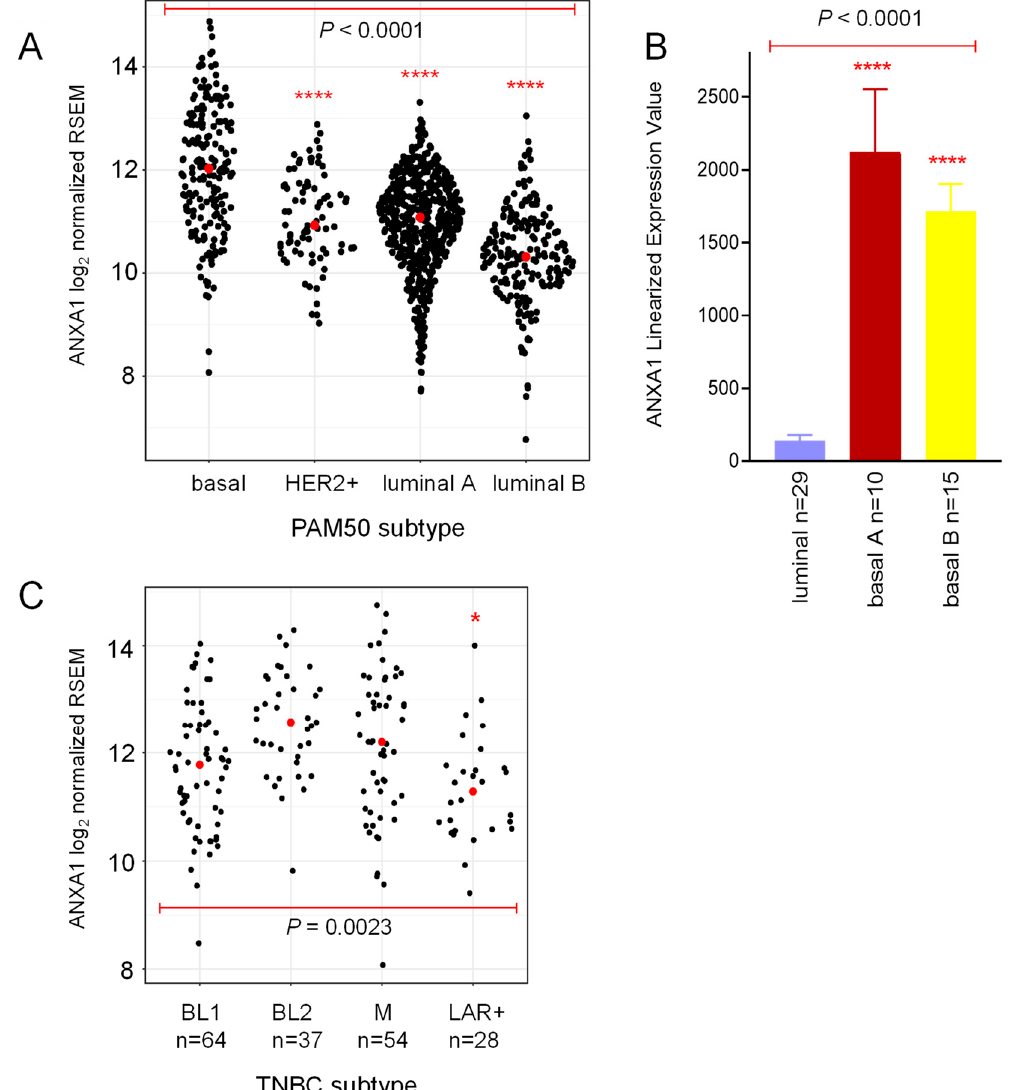
Figure 1. Annexin A1 is highly expressed in basal-like breast cancer. ( A ) Expression of Annexin A1 (log 2 normalized RSEM) in 1081 primary human breast cancers from the The Cancer Genome Atlas (TCGA) dataset [38]. Tumors were allocated to one of four intrinsic molecular subtypes using the PAM50 gene set [41]. Annexin A1 was differentially expressed across the subtypes (one-way ANOVA p < 0.0001) and was significantly higher in basal-like tumors than either HER2+, luminal, or luminal B (each p < 0.0001, ****). ( B ) Annexin A1 mRNA levels in human breast cancer cell lines [42]. Mean ± SEM. One-way ANOVA p < 0.0001. ER+ luminal v basal A ( p < 0.0001, ****), luminal v basal B ( p < 0.0001, ****), basal A v basal B ( p > 0.05). ( C ) Annexin A1 mRNA expression (log 2 normalized RSEM) in the four different subtypes of TNBC [5,6]. BL1 ( n = 64), BL2 ( n = 37), M ( n = 54), LAR ( n = 28). One-way ANOVA p = 0.0023. BL2 v LAR ( p < 0.05, *).